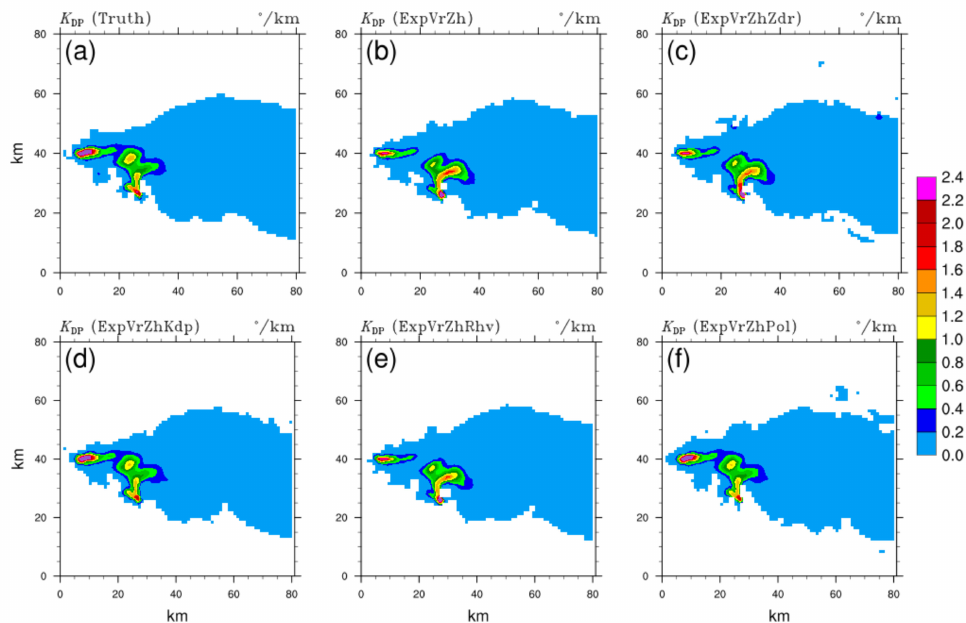
Figure 5. The same as Figure 3, but for the specific differential phase K DP (unit: ◦ /km) of ( a ) truth, and analysis fields of ( b ) ExpVrZh, ( c ) ExpVrZhZdr, ( d ) ExpVrZhKdp, ( e ) ExpVrZhRhv, and ( f ) ExpVrZhPol,